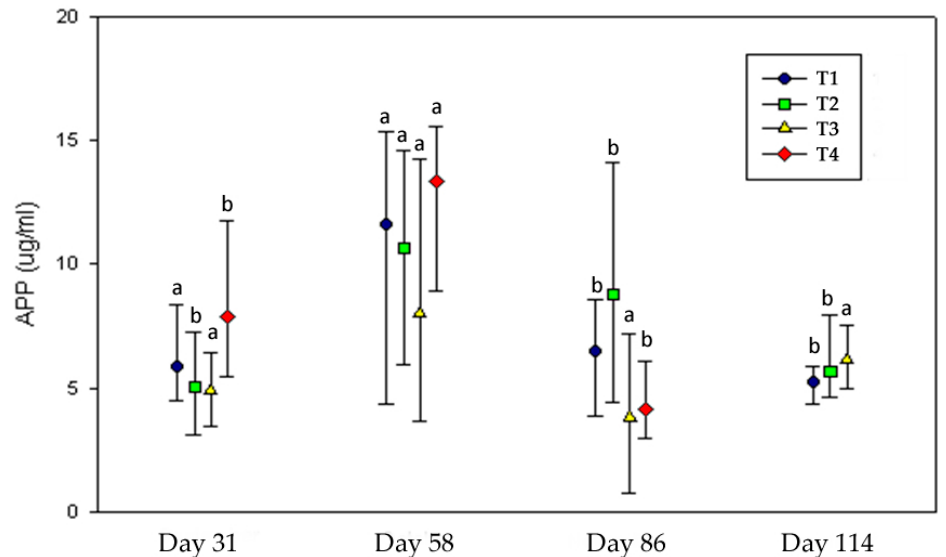
Figure 4. Acute phase protein (APP) concentration in the different treatments throughout the experiment. Lines represent the median, 25th, and 75th percentile values. a,b Medians within the same treatment at different dates differ with p < 0.05. Animals from T4 were already slaughtered at day 114.